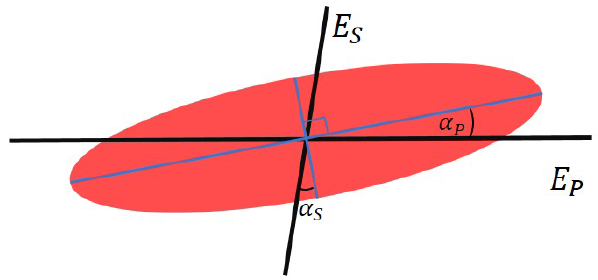
Figure A1. Scheme of the observation of the polarization state of the backscattered light (similar to Fig. 3). The co-polarized and cross-polarized channels are misaligned with respect to their com- ponents at angles α P and α S ,